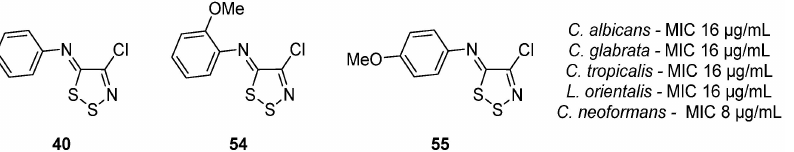
Figure 8. Report on a small panel of 1,2,3-dithiazoles highlighted some nascent antifungal activity on the dithiazole scaffold.